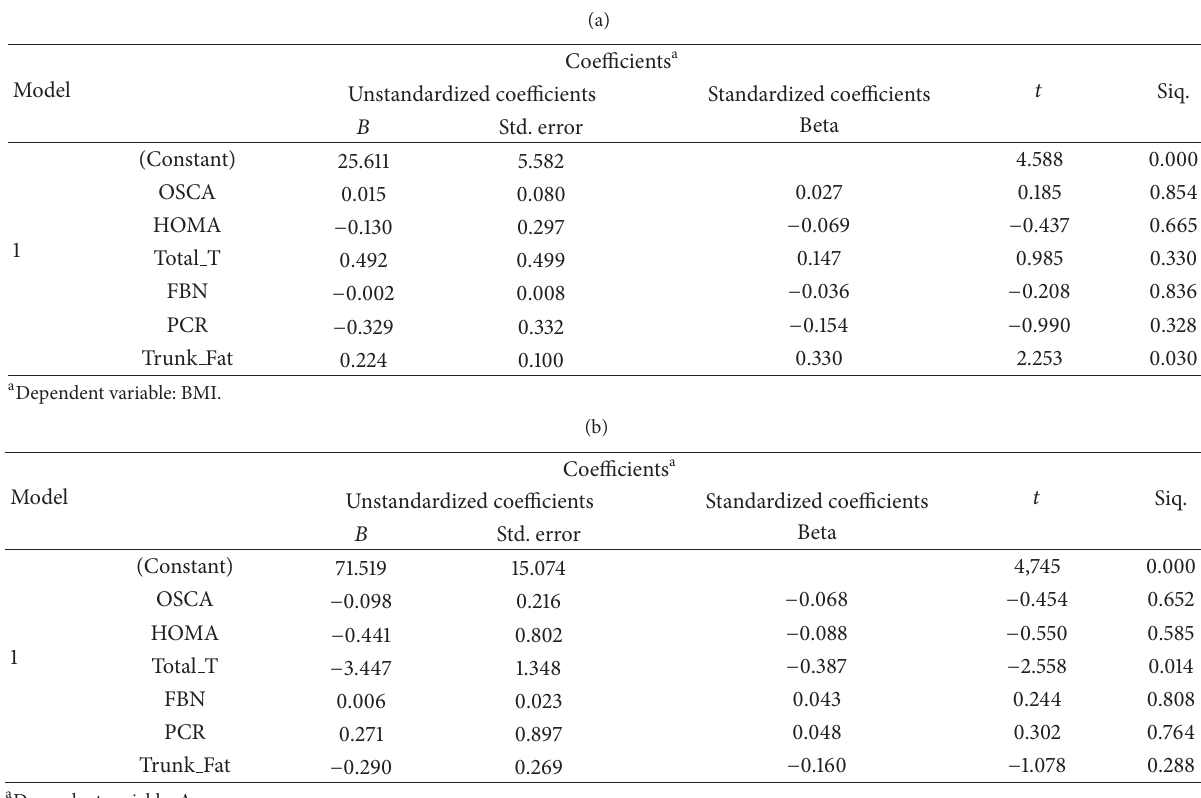
Table 2: (a) Regression analysis: Trunk fat is an independent variable from BMI. (b) Regression analysis: total T levels is an independent variable from